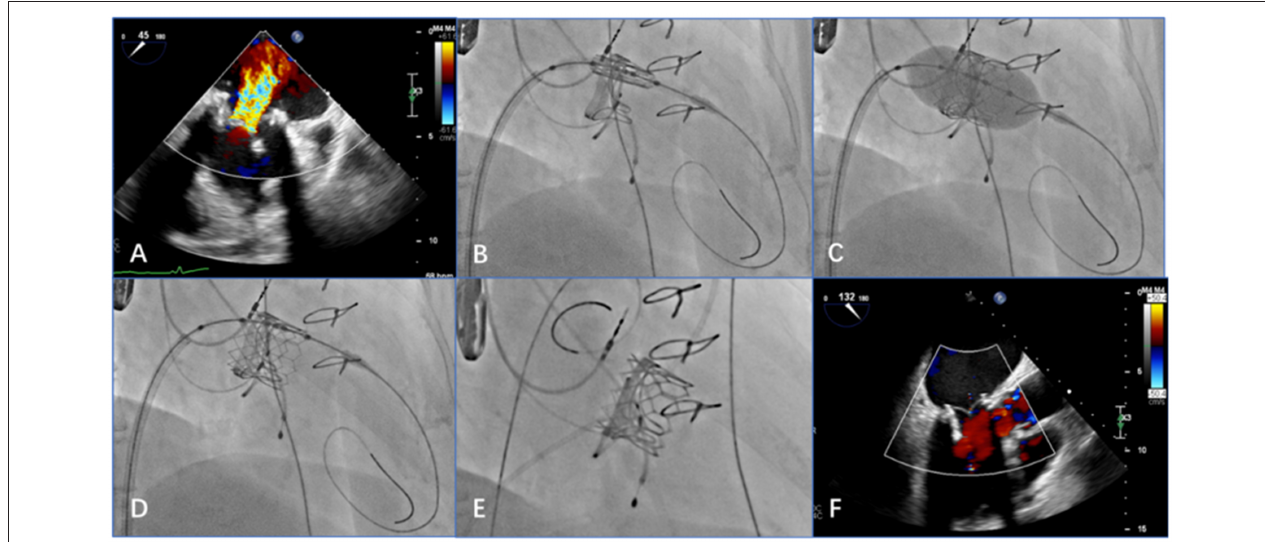
FIGURE 4 | Transesophageal echocardiography (TEE) and digital subtraction angiography images show that the procedure achieved good results (e.g., data from patient 2). (A) Preprocedural TEE displays a large amount of colorful blood flow at the mitral valve. (B) The delivery system is positioned in relation to the mitral valve via the atrial septum. (C) After adjusting the position and the coaxiality, the balloon-expandable valve is inflated. (D) After expansion, the stent is fully unfolded. (E) When the guide wire is withdrawn, digital subtraction angiography shows that the position and shape of the mitral valve are ideal and that the stent fits closely to the valve. (F) Post-procedural TEE shows that the balloon-expandable valve is properly closed, with no paravalvular regurgitation.